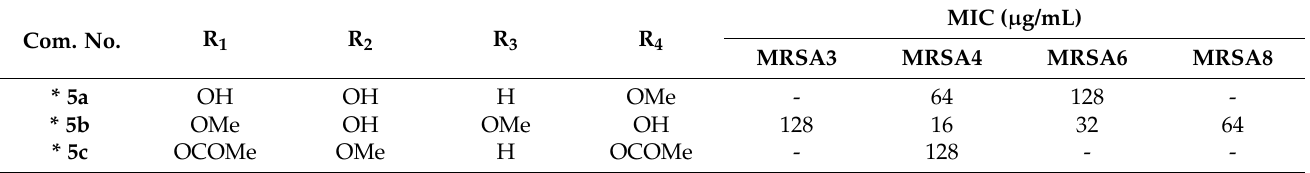
Figure 18. Structural activity of chalcones against MRSA strains [84].